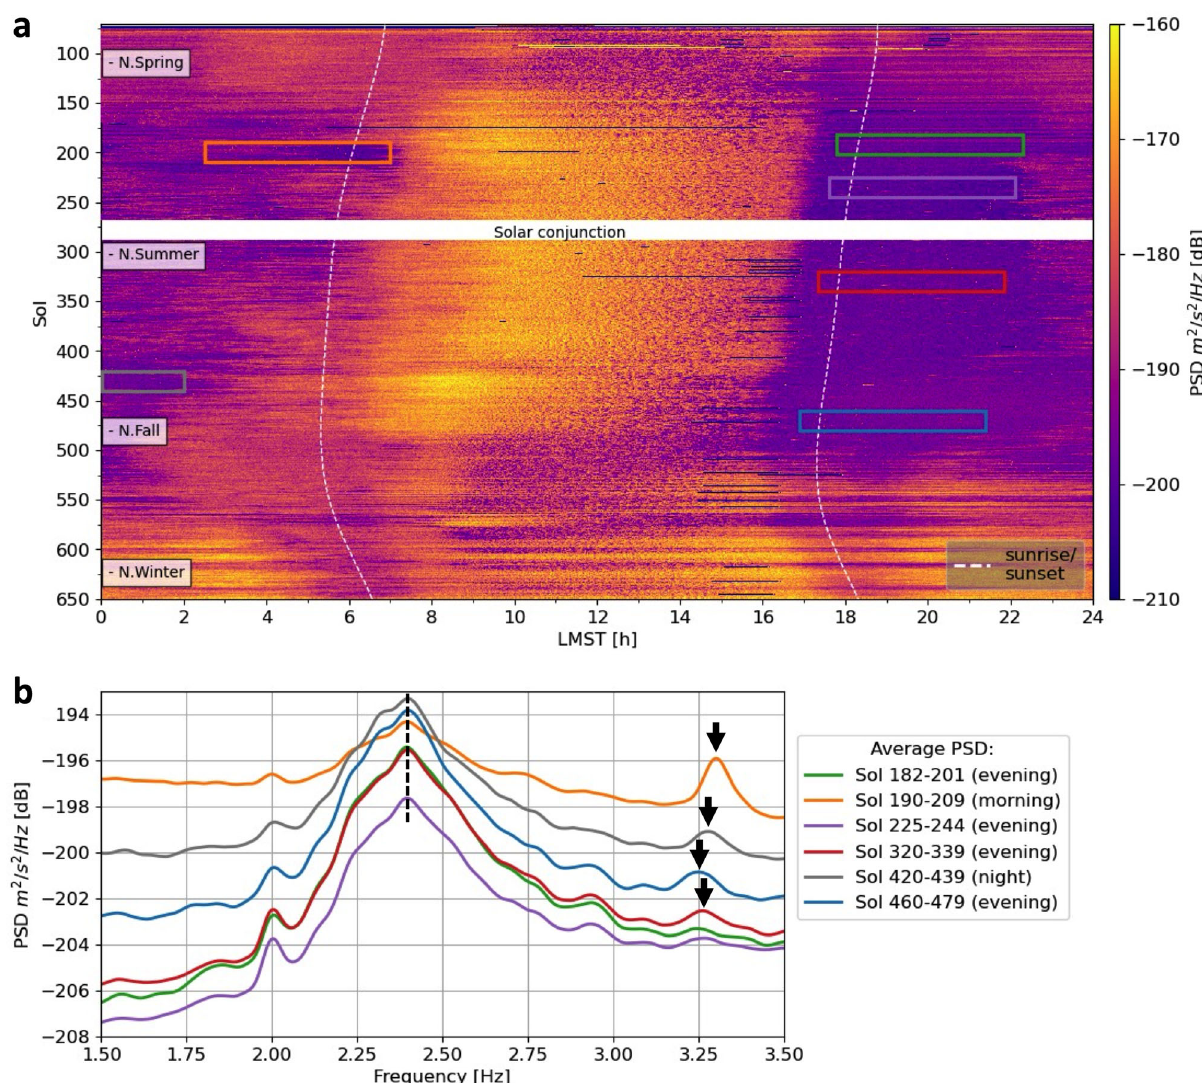
Fig. 1 2.4 Hz mode observation across the InSight mission. a Vertical-component energy between 2.3 and 2.5 Hz for sols 80 − 650. Each row corresponds to the data from one sol plotted against local mean solar time (LMST). Vertical white dashed lines indicate sunrise and sunset. b Power spectral density (PSD) plots averaged over 20 sols extracted for the time windows marked in the spectrogram in ( a ). Note speci fi cally the stable shape of the peak around 2.4 Hz across the entire mission duration. Evenings are generally quieter and more stable than any other time of day. The peak power level of the 2.4 Hz mode marked by the dashed line weakly depends on the wind speed 17 . In comparison, the lander-related mode at 3.3 Hz (black arrows) changes its peak frequency and amplitude level considerably depending on wind and